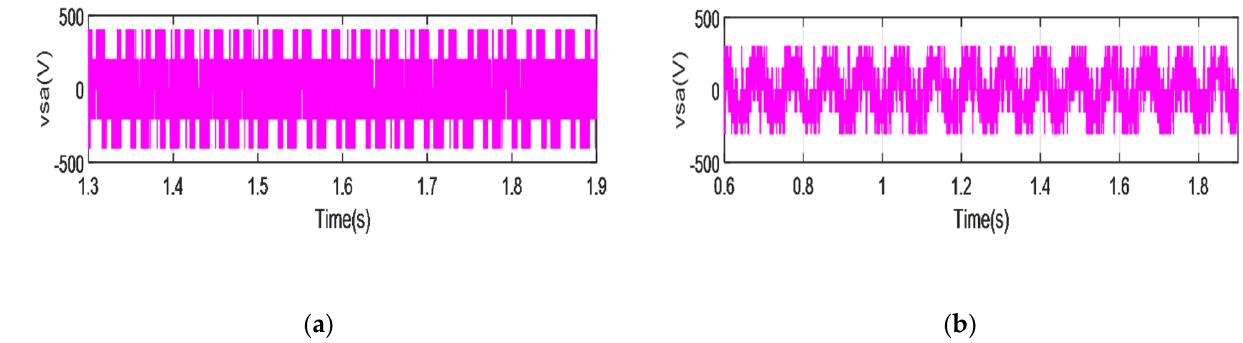
Figure 7. Output voltage of the inverter: ( a ) conventional inverter; ( b ) five-level inverter.